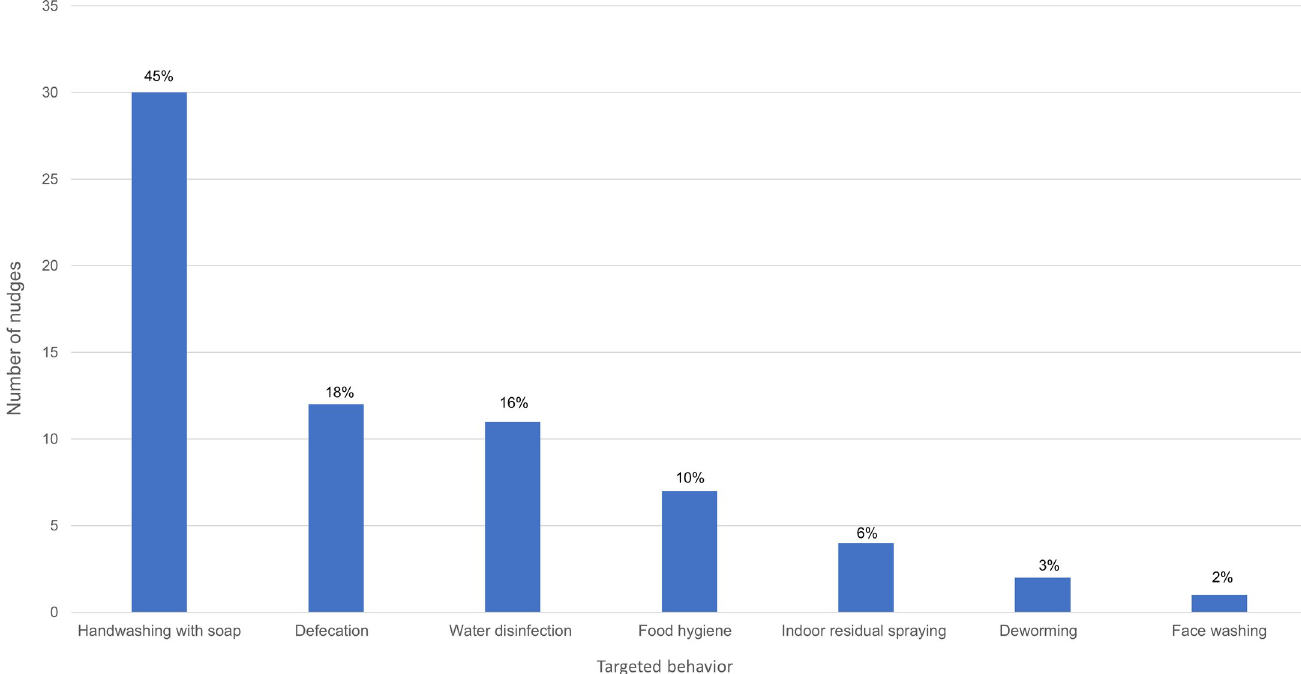
Fig 2. Number of nudges included in the review (n = 67), targeting different behaviors: Handwashing with soap; Defecation behaviors; Water disinfection; Food hygiene; Indoor residual spraying; Deworming; Face wahing.